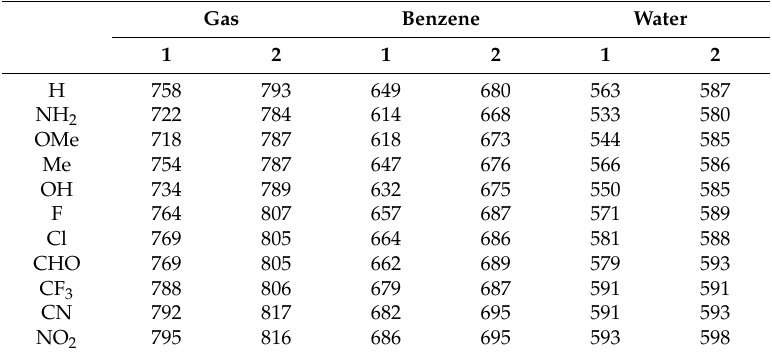
Table 3. Ionization potential (IP) in kJ/mol obtained by the M062X/6-311 + G**